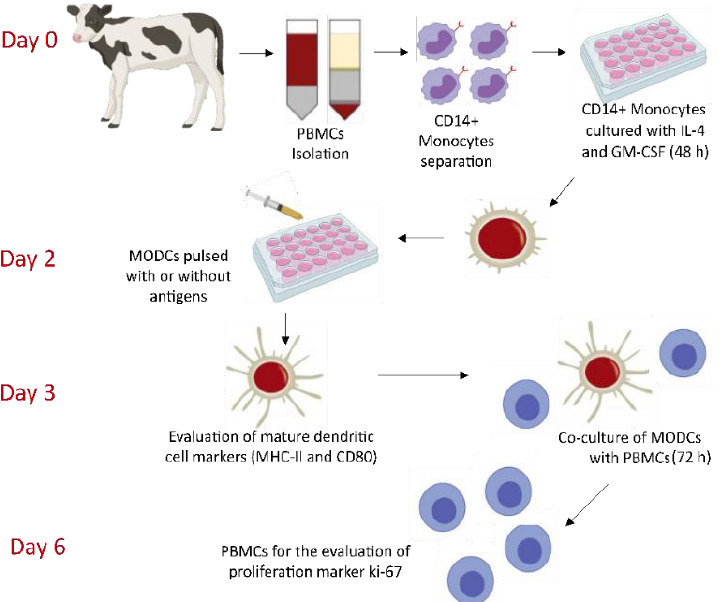
Figure 3. Determination of antigen expression on the surface of recombinant phages. ( A ) Curve of mean area vs mole of recombinant yellow fluorescent protein (YFP) that contains a His-tag was used to determine by densitometry analysis the mole of antigen expressed per PFU unit. Different quantities of YFP were applied in duplicate. Different concentrations of yellow fluorescent protein were used to construct a standard curve for densitometry analysis. For phage samples, 1 × 10 11 PFU per dot were applied. ( B ) Determination of mole and µ g of protein (Sbm7462 antigen) per phage unit (PFU). R, replicate. Control +, phage expressing a tetanus toxin Fab, VCSM13, negative control phage. Sbm7462, phage-based vaccine (Antigen Sbm7462 displayed on phage).